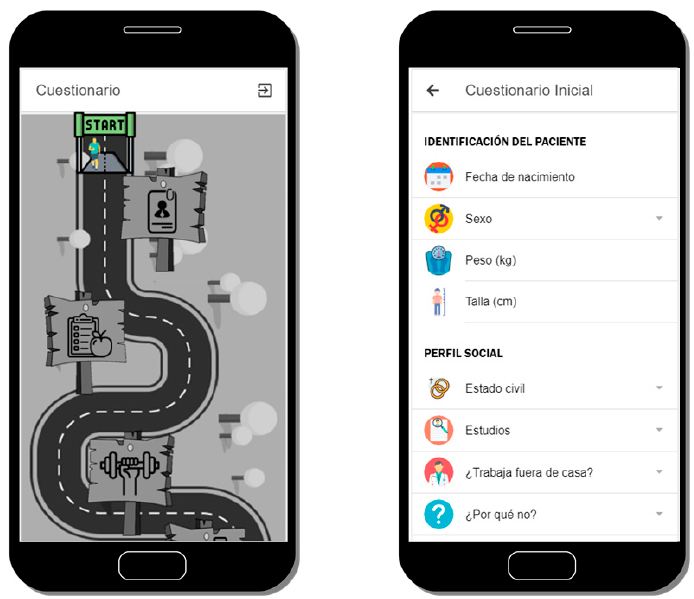
Figure 3. Main interface to navigate through all the life habits questionnaire’s sections (left) and detail of the first section of the questionnaire (right).